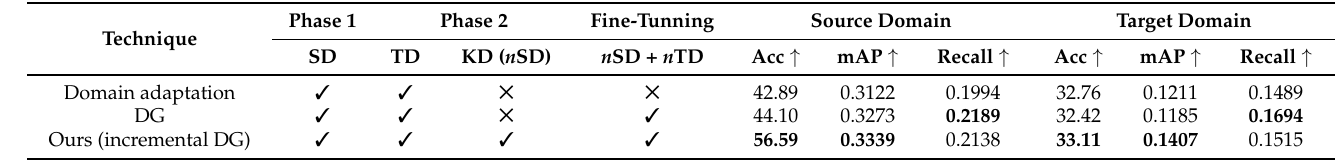
Table 2. Comparison of the model performance trained using our proposed knowledge distillation (KD)-based incremental DG technique against the performances of models trained using naive domain adaptation and DG techniques on the source domain (SD) and target domain (TD).